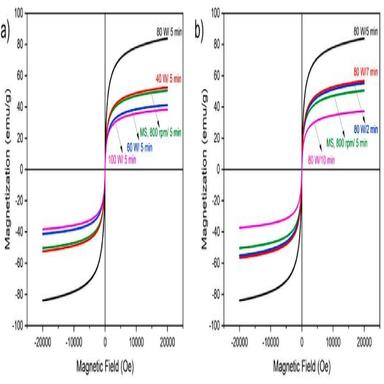
Magnetic hysteresis loops of MCNC prepared by MS (800 rpm/5 min) and under different sonication conditions. a) Different sonication power of 40 W, 60 W, 80 W and 100 W for 5 min; b) Different sonication time of 2 min, 5 min, 7 min and 10 min. MCNC, magnetic cellulose nanocrystals; MS, mechanical stirring.